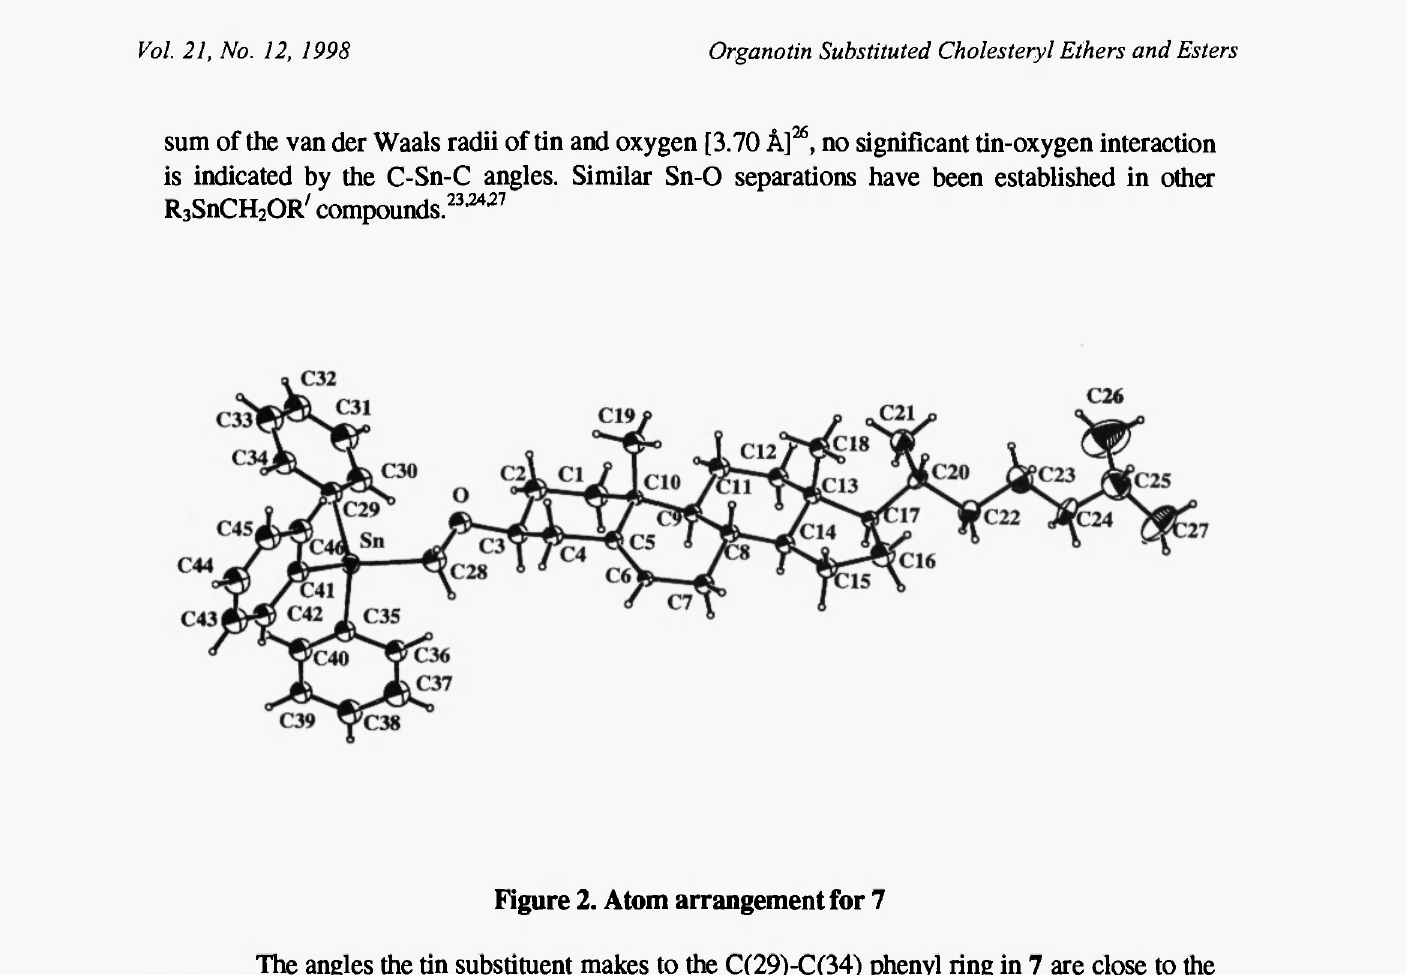
Figure 2. Atom arrangement for 7